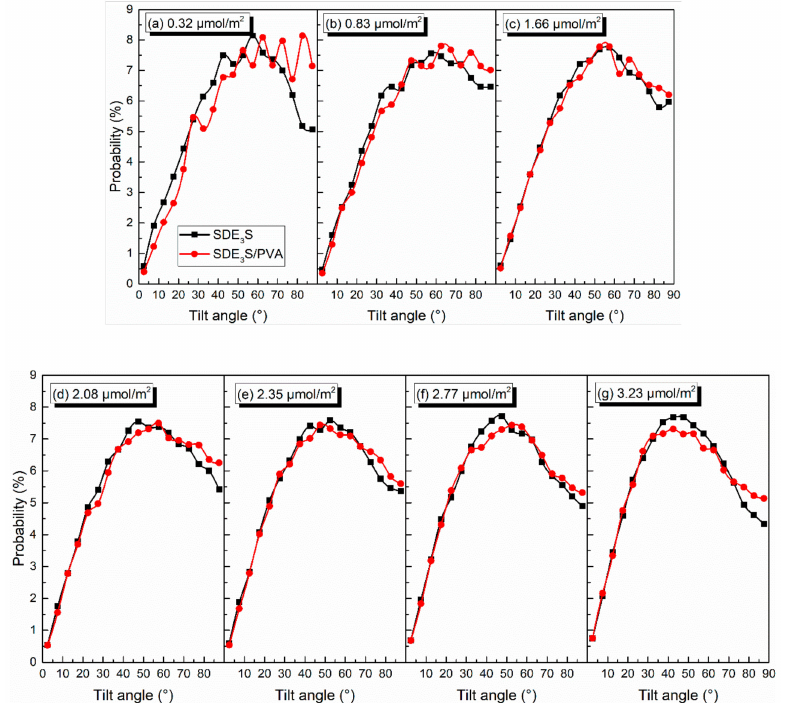
Figure 12. Comparison of tilt angles of θ EO1 in SDE 3 S and SDE 3 S / PVA systems: ( a ) 0.32 µ mol / m 2 ; ( b ) 0.83 µ mol / m 2 ; ( c ) 1.66 µ mol / m 2 ; ( d ) 2.08 µ mol / m 2 ; ( e ) 2.35 µ mol / m 2 ; ( f ) 2.77 µ mol / m 2 ; ( g ) 3.23 µ mol / m 2 .